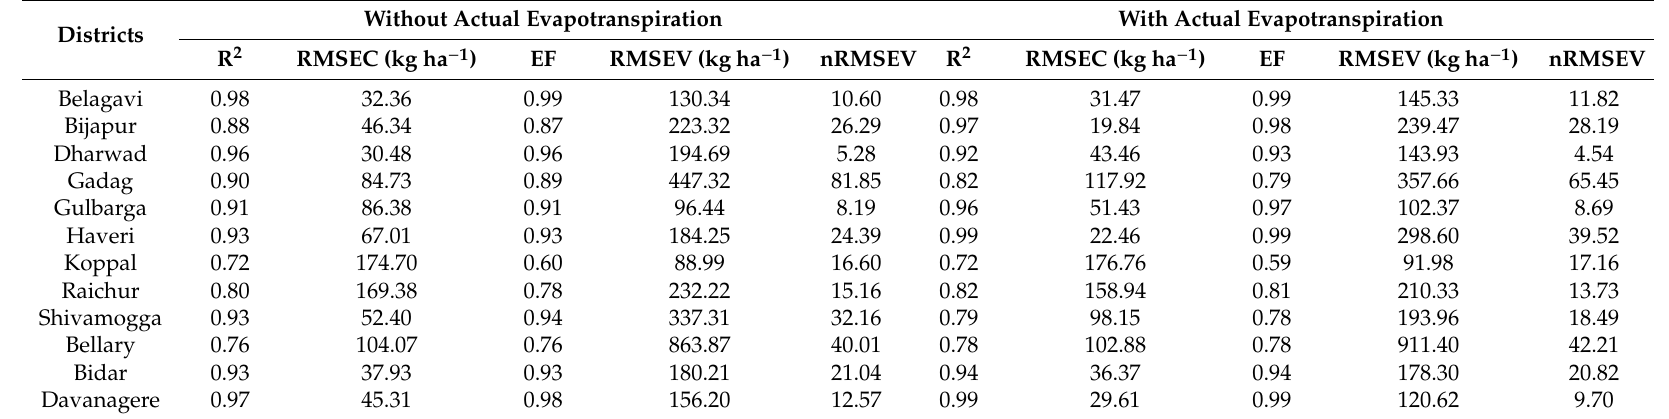
Table 3. Quantitative measures obtained for sorghum yield prediction of Karnataka using LASSO.